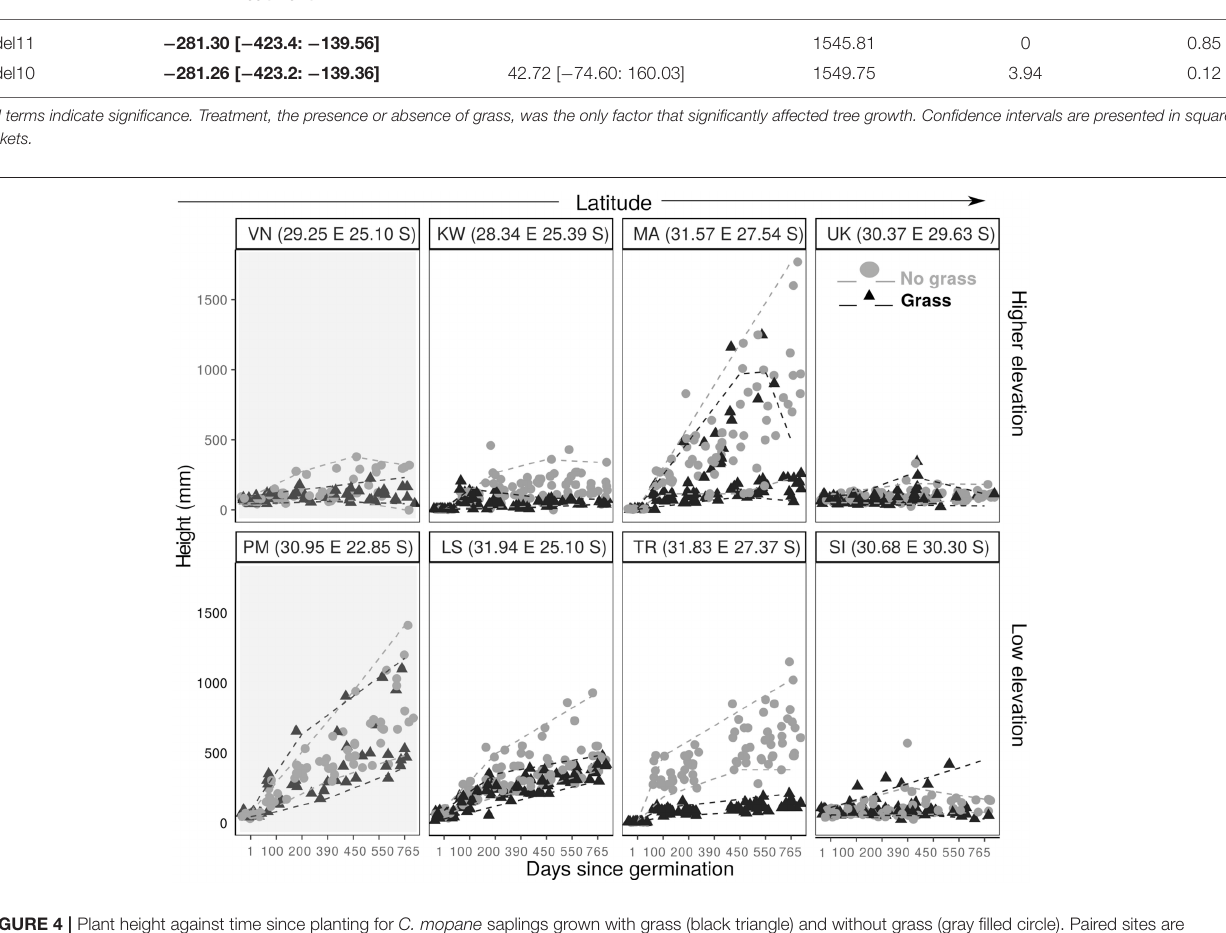
FIGURE 4 | Plant height against time since planting for C. mopane saplings grown with grass (black triangle) and without grass (gray filled circle). Paired sites are arranged (L–R) in order of increasing latitude, with higher elevation sites in the top panel and lower elevation sites in the bottom panel. The dashed lines demonstrate the 5th and 95th quantiles for grassy plots (gray) and non-grass plots (black). Shaded graphs indicate a site which is within the distribution